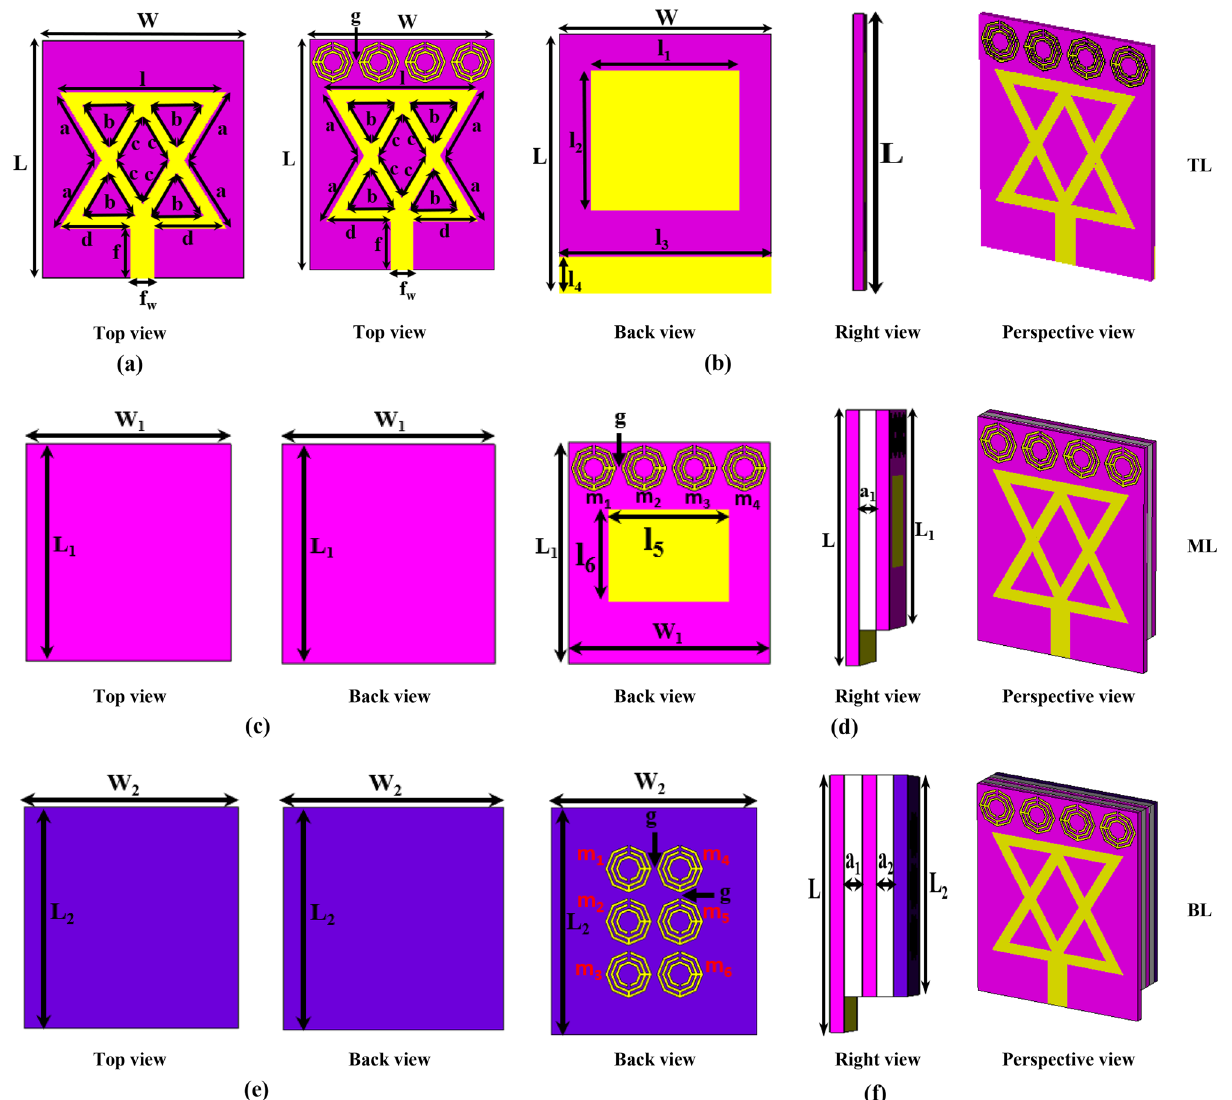
Figure 3. Proposed antenna geometry and evolution development: ( a ) Antenna-1(TL, without MTM); ( b ) Antenna-2 (TL, with MTM); ( c ) Antenna-3 (ML, without MTM); ( d ) Antenna-4 (ML, with MTM); ( e ) Antenna-5 (BL, without MTM); ( f ) Proposed antenna (BL, with MTM).